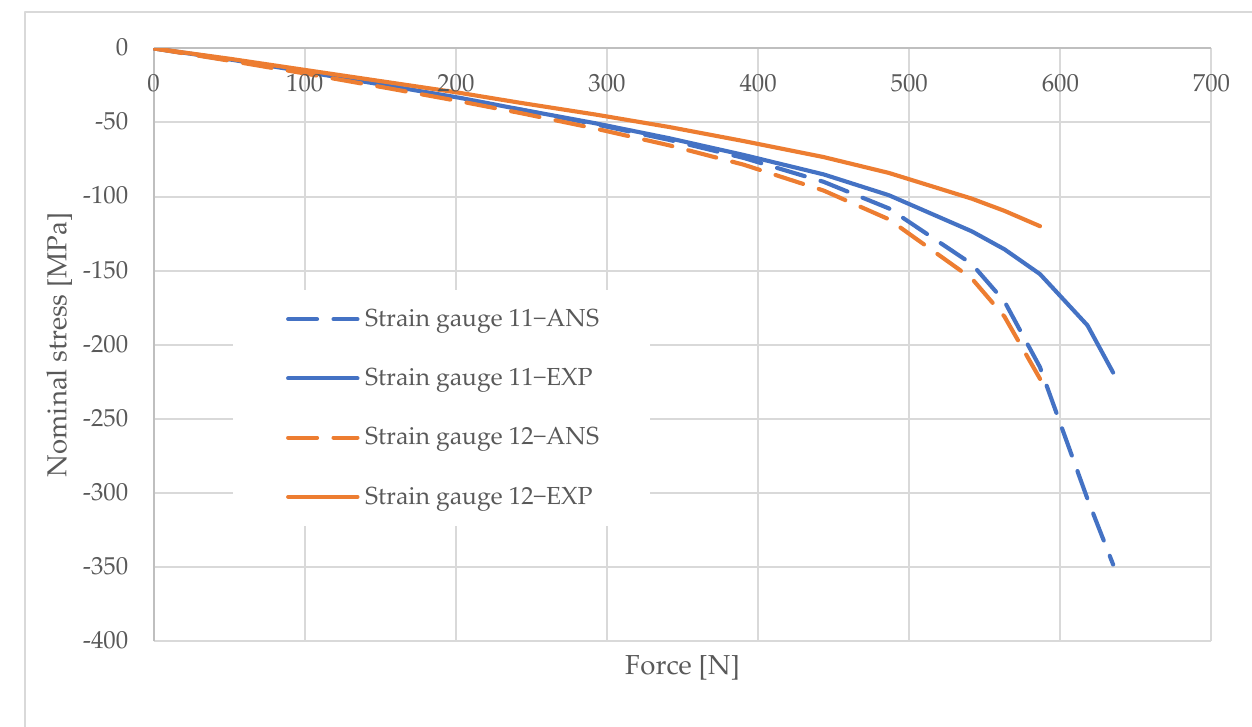
Figure 10. Pole 5/2 — values of normal stress readings from strain gauges no. 1, 4, and 7.